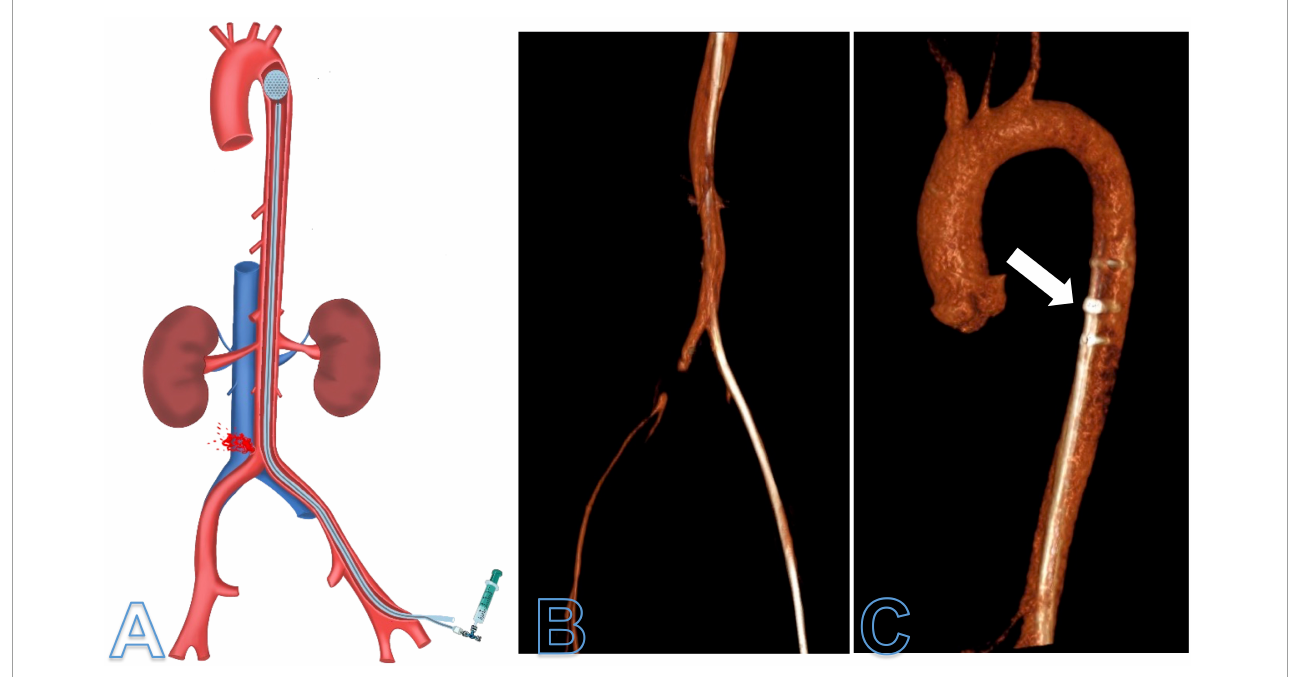
FIGURE1 Illustration (A) and computed tomography angiography (CTA) reconstruction (B,C) of the deflated resuscitative endovascular balloon occlusion (REBOA) balloon in REBOA zone I (C) . CTA was performed after surgical bleeding control of the right common iliac artery was achieved. The 12Fr sheath and deflated aortic balloon were kept within the thoracic aorta (arrow) to enable additional aortic occlusion at any time during